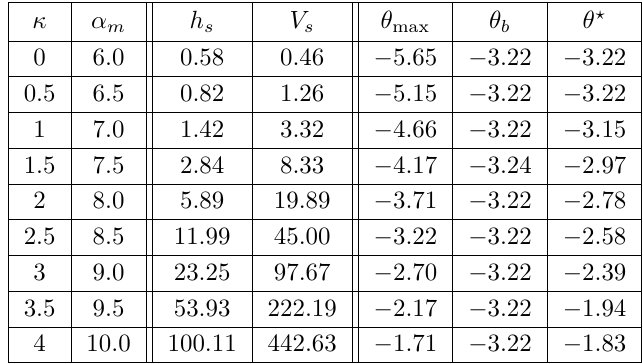
Table 1 . Spectral density’s persistent peak data for σ = 12 , α a = 3 .